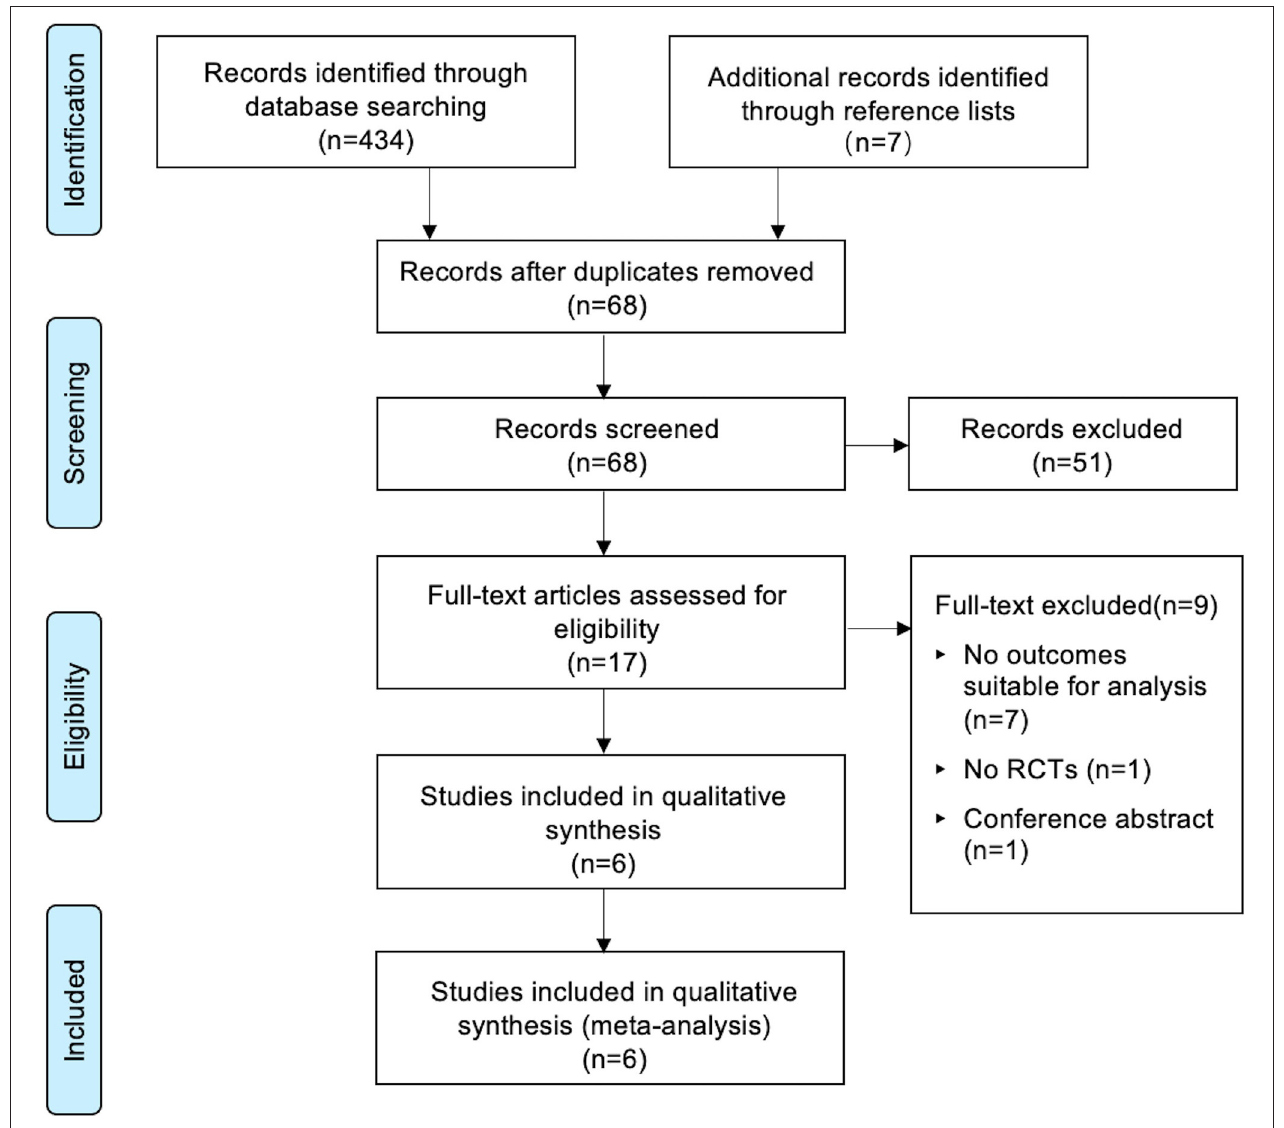
FIGURE 1 | Flowchart of the study